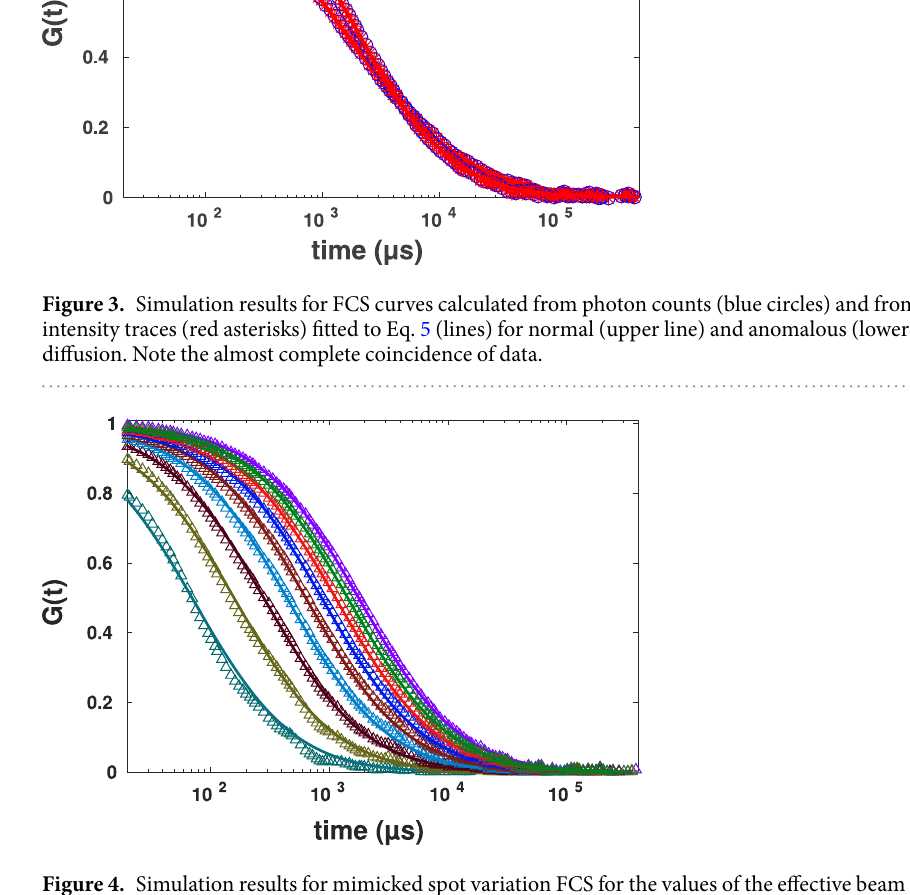
Figure 4. Simulation results for mimicked spot variation FCS for the values of the effective beam waist ranging from r 0 to 0.2 r 0 (from right to left) for normal diffusion (symbols), together with theoretical FCS curves for the same beam waists according to Eq.